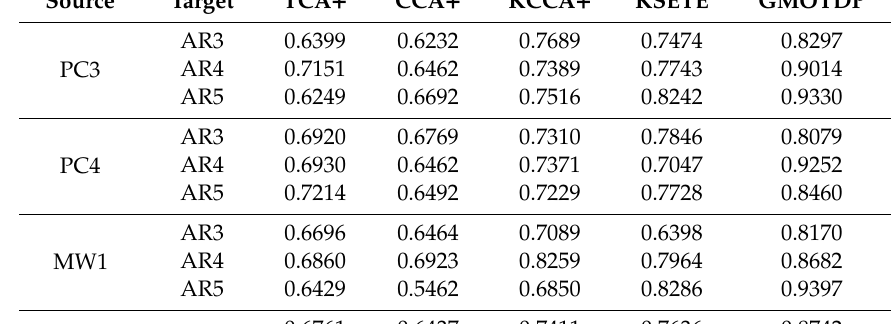
Table 4. Mean AUC results for source and target projects with common features using di ff erent methods.